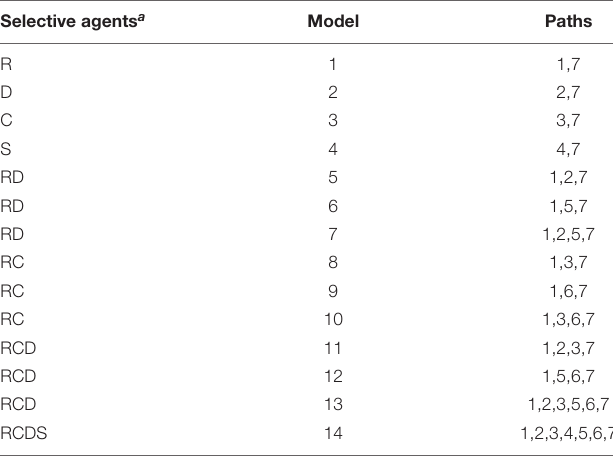
TABLE 4 | List of the a priori 14 candidate models of the effect of the four putative selective agents. Selective agents a Model